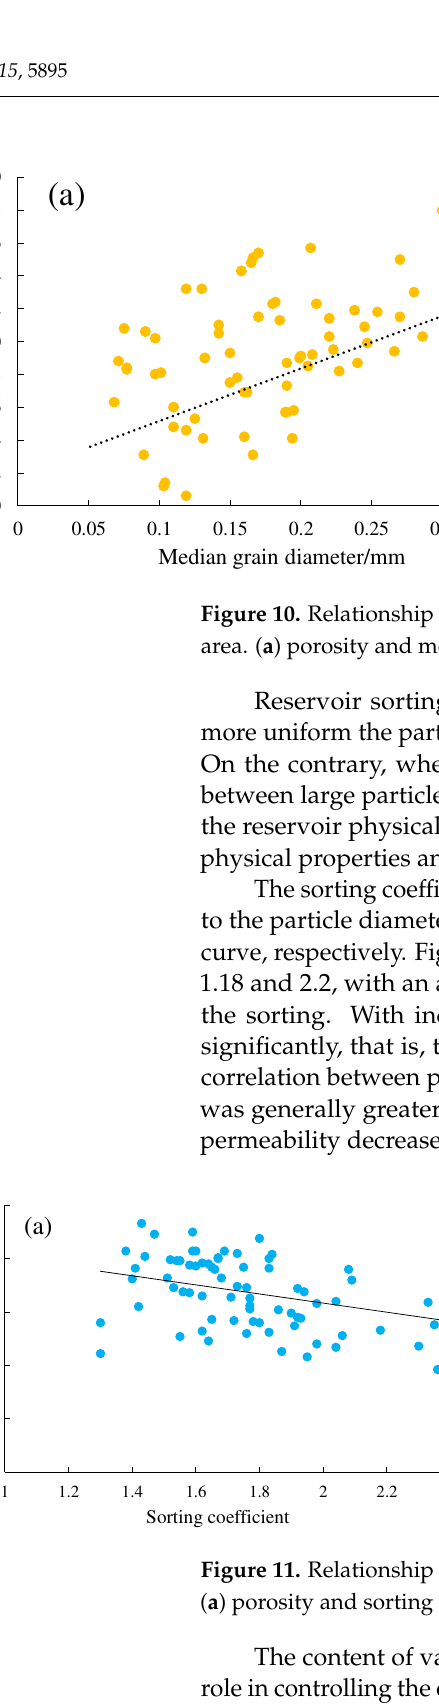
21.2 Figure 9. Correlation between clastic composition and porosity of Ek1 Formation in the Wang Guan- tun area. ( a ) porosity and quartz volume fraction; ( b ) porosity and feldspar volume fraction; ( c ) porosity and rock debris volume fraction. 5.1.2. Control of Sedimentary Fabric on Reservoir Quality